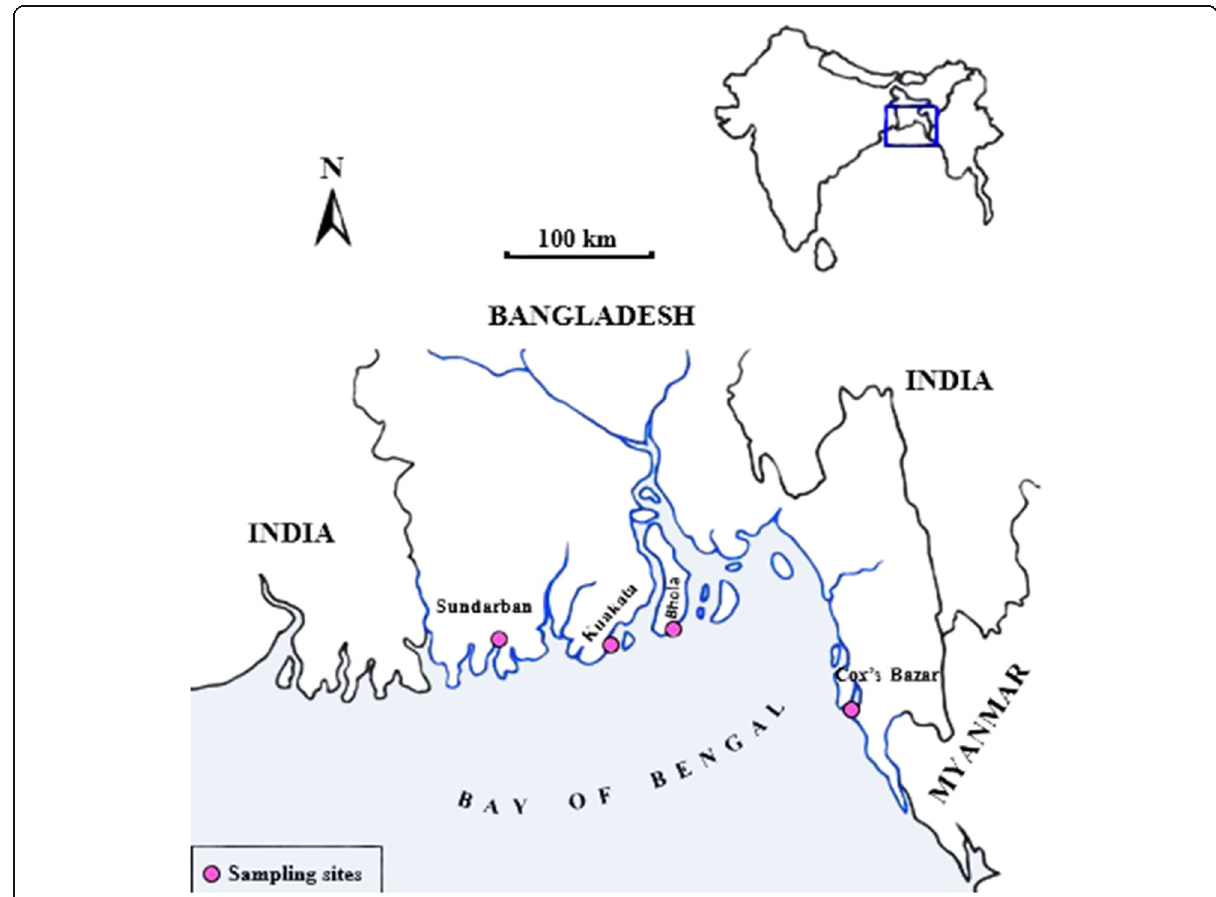
Fig. 1 Sampling locations of sardine A. clupeoides samples from Cox ’ s Bazar, Kuakata, Bhola, and Sundarbans along the Bay of Bengal coast,